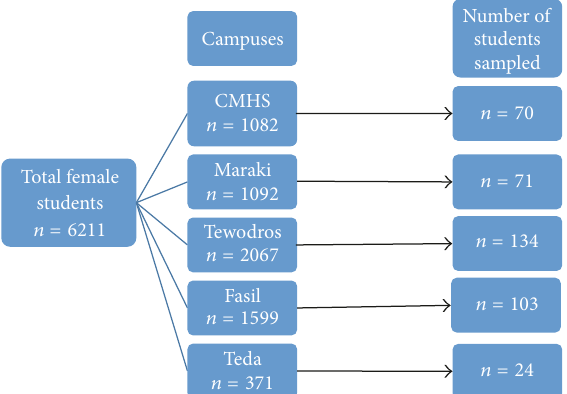
Figure 1: Flowchart of sampling procedure (selected from each campus using simple random sampling technique).